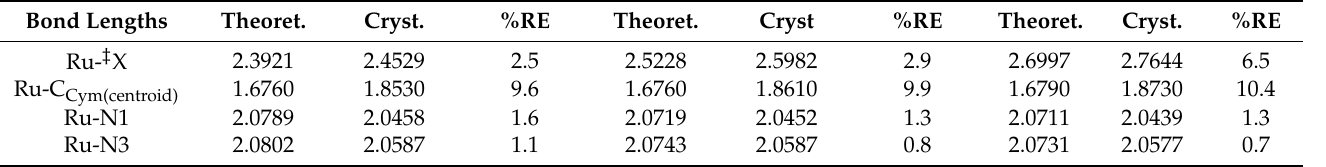
Table 5. Comparison of selected DFT data metrics with that from the crystal structure for complexes Ru1 - 3.